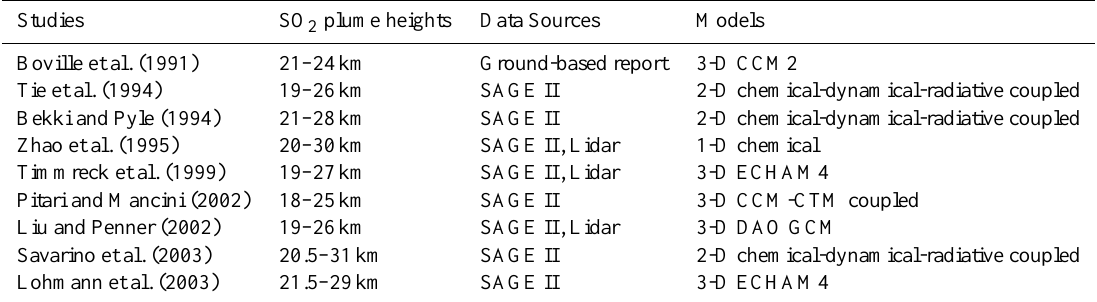
Table 1. Volcanic SO 2 plume modeling studies for the 1991 Pinatubo